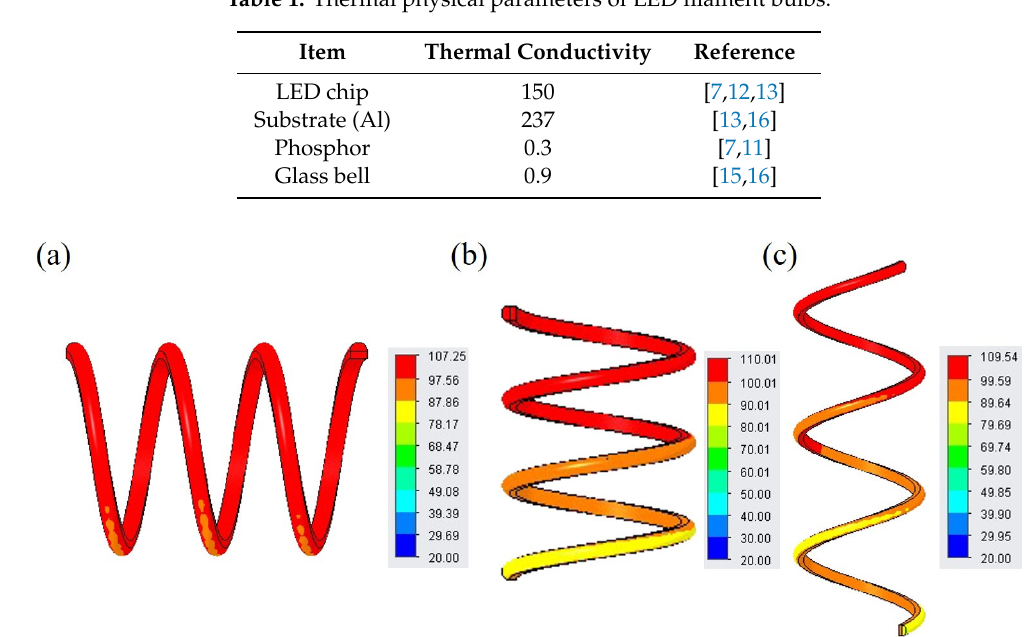
Table 1. Thermal physical parameters of LED filament bulbs.